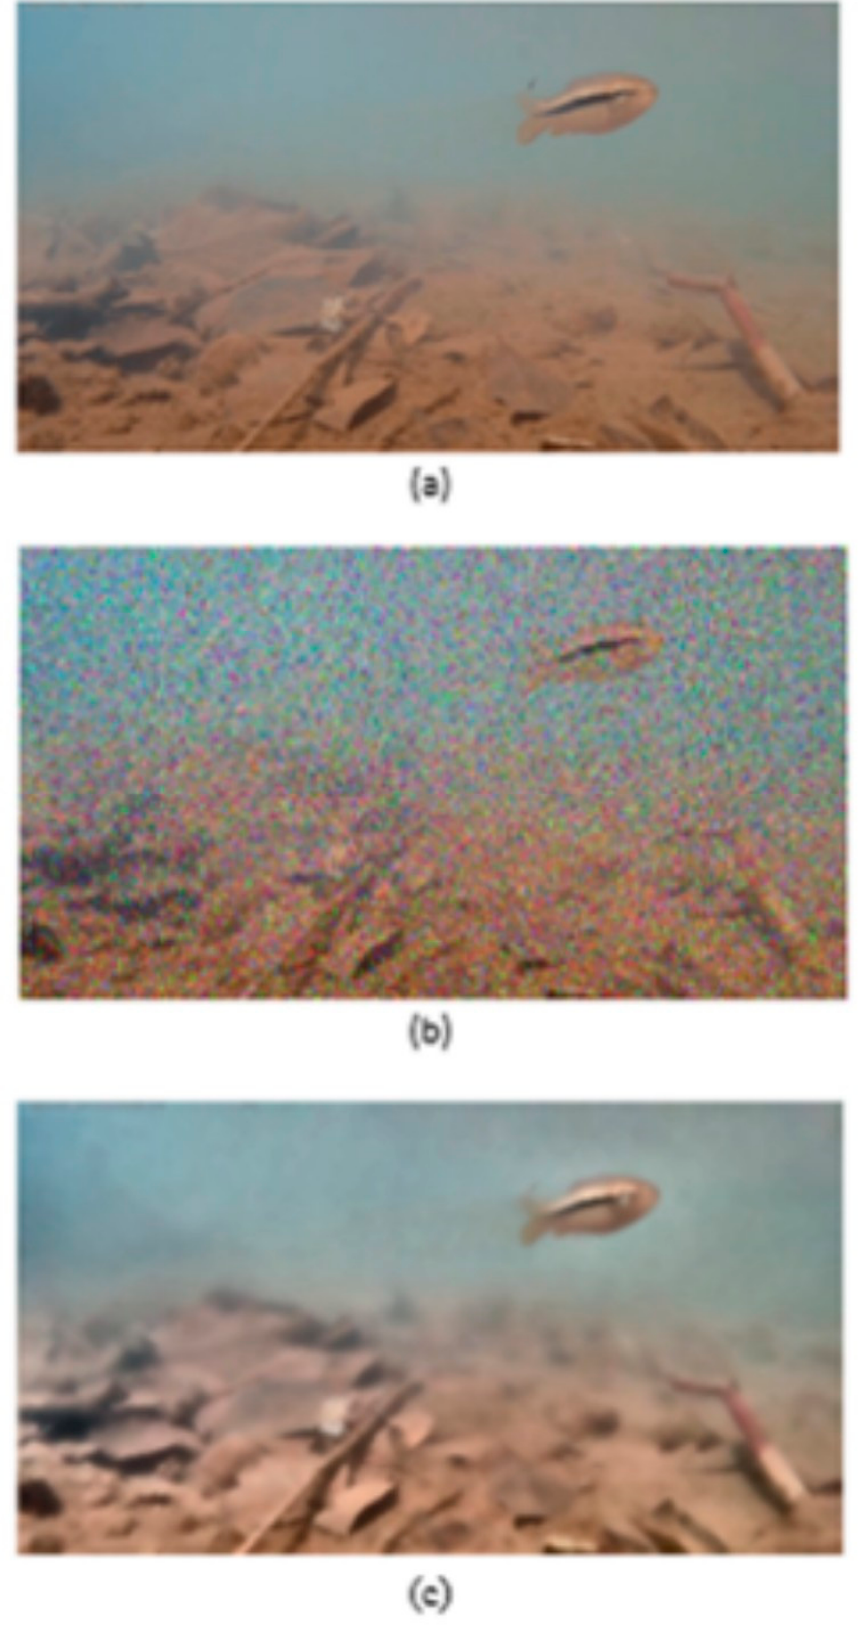
Figure 5. ( a ) Ground Image (SNR = 47.85), ( b ) Noise image with S&P (SNR = 15.23), ( c ) Reconstructed Image (SNR = 17.8).